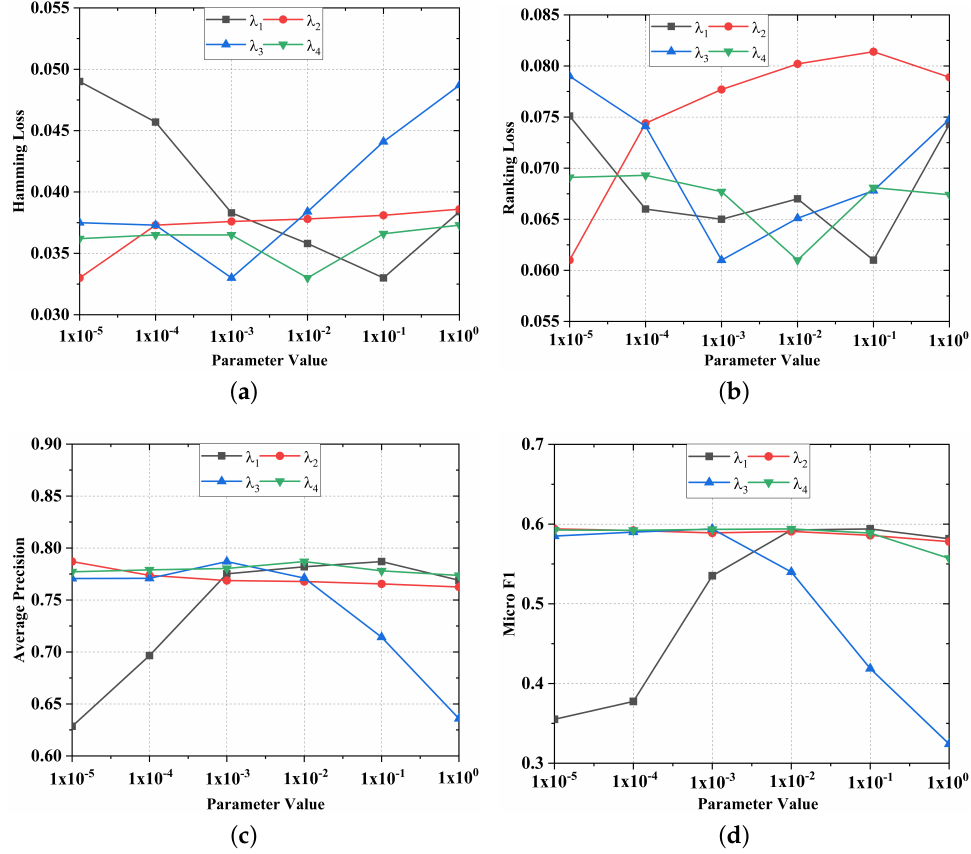
Figure 6. Performance fluctuations of λ 1 , λ 2 , λ 3 , and λ 4 on the health dataset with 20% noisy features and missing labels on metric (a) Hamming Loss , (b) Ranking Loss , (c) Average Precision , and (d) Micro F1